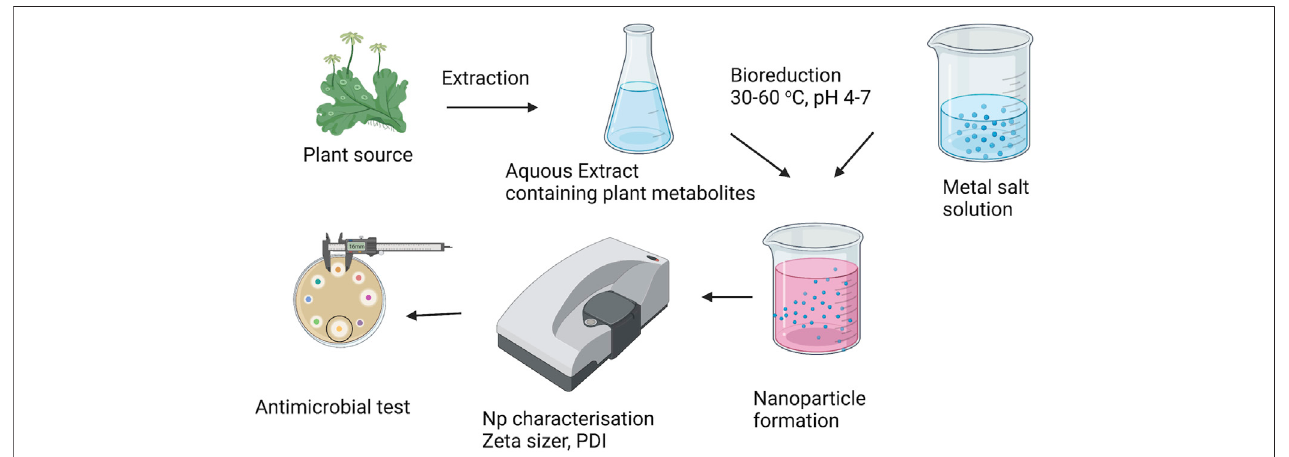
FIGURE 2 | Schematic representation for plant-mediated biosynthesis of